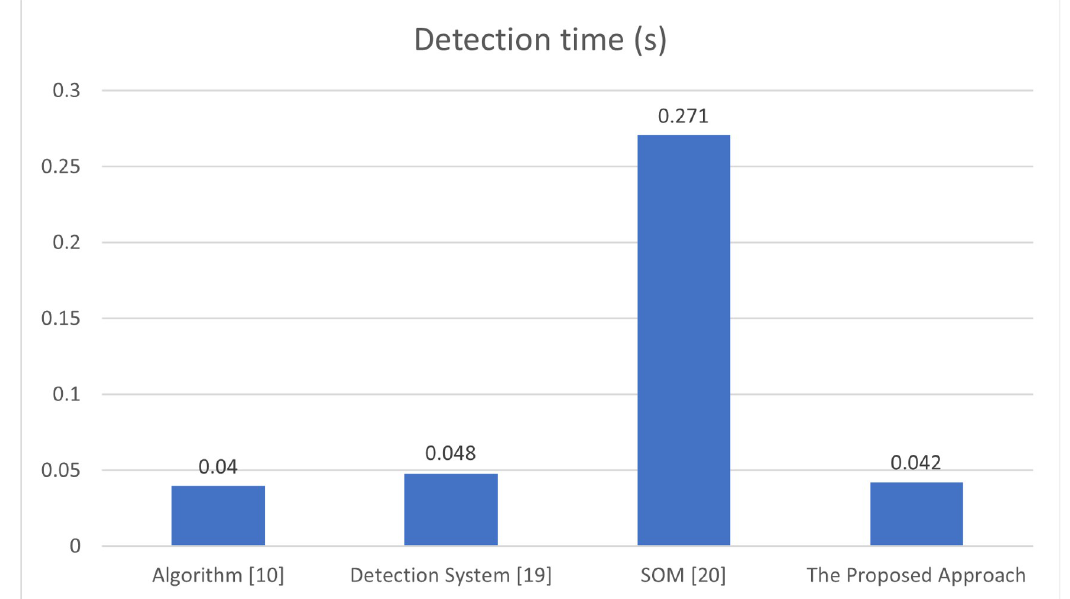
Fig 9. Comparison of detection time of algorithm [10], detection system [19], detection method [20], and the proposed approach.